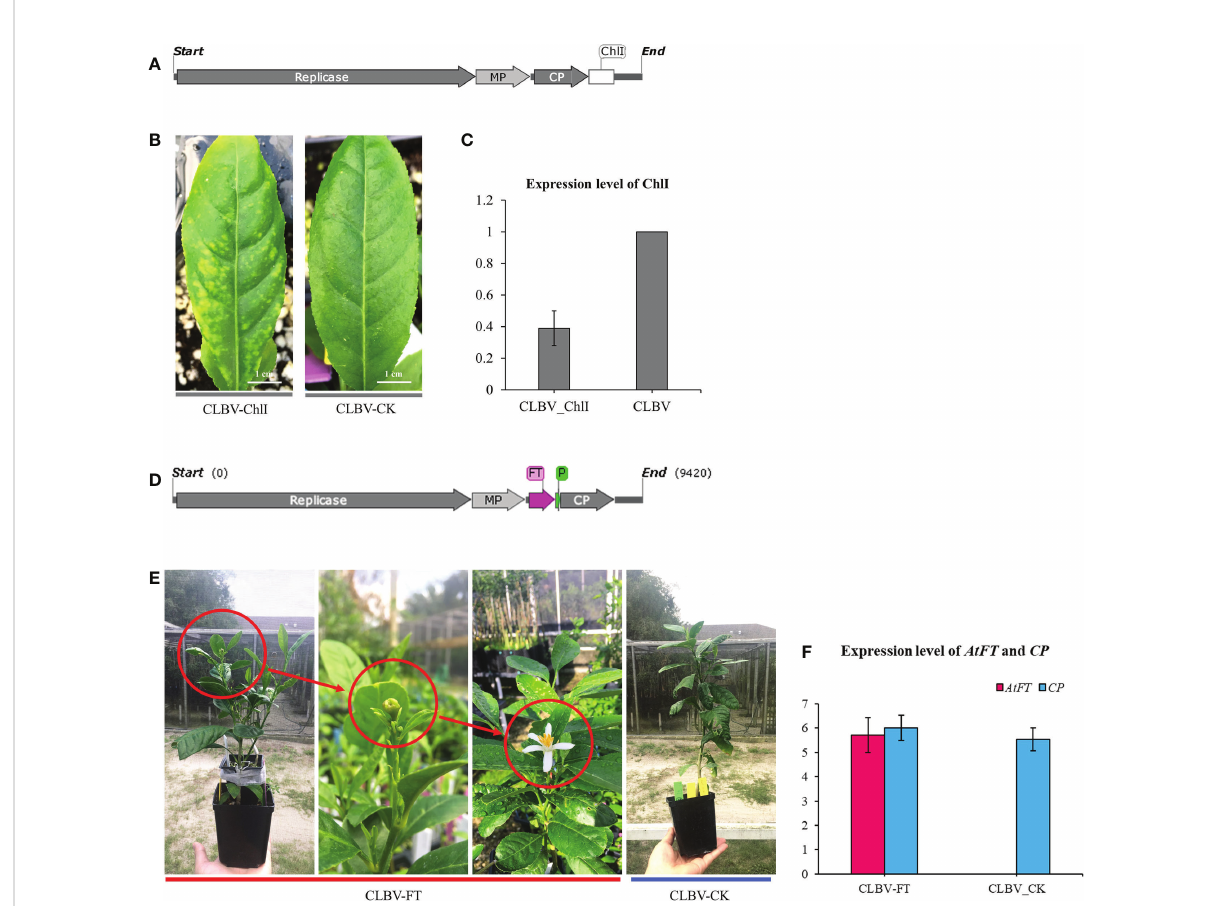
FIGURE 6 Agrobacterium rhizogenes -mediated citrus genetic transformation promotes the virus-induced application on citrus. (A) Schematic diagrams of the CLBV-ChlI vector. (B) Silencing phenotype of Citrus medica inoculated with wild-type CLBV (CLBV-CK) and CLBV-ChlI. (C) Relative accumulation of ChlI mRNA in C . medica inoculated with CLBV_CK or with CLBV_ChlI. (D) Schematic diagrams of the CLBV-FT vector generated by cloning the FT gene from Arabidopsis thaliana . (E) Flowering of a juvenile C . medica inoculated with the CLBV-FT. The juvenile C . medica inoculated with CLBV-CK did not fl ower. (F) Expression of AtFT